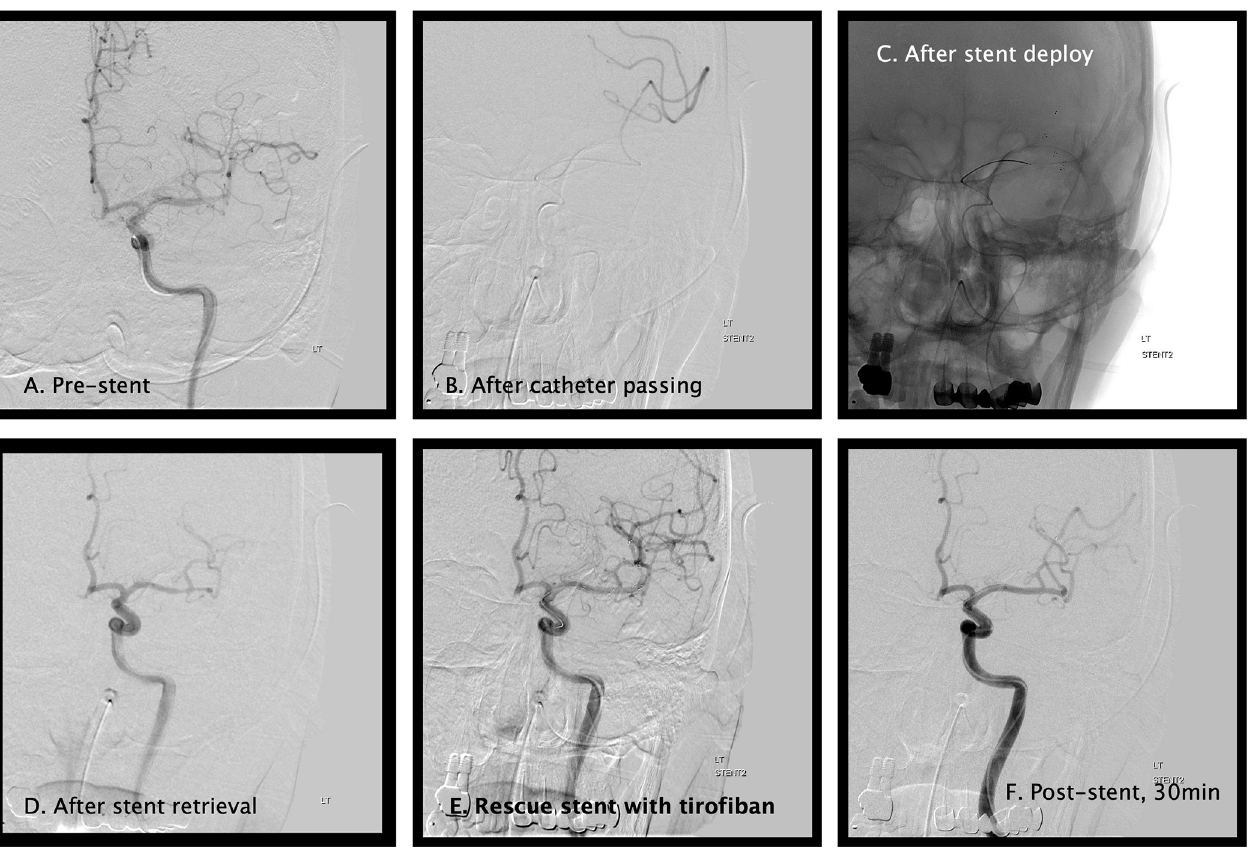
Fig 2. Intraoperative angiograms during RS deployment. The angiogram shows occlusion of the left M2 superior branch (A). The micro-angiogram visualizes the peripheral arterial flows after passing the occlusion site (B). Despite several attempts at stent deploying and retrieving (C), failed thrombectomy of TICI 0 is observed (D). Finally, the RS is permanently deployed (E), and recanalization of the superior M2 is shown after 15 minutes in an angiogram (F). RS, rescue stent; TICI, thrombolysis in cerebral ischemia.